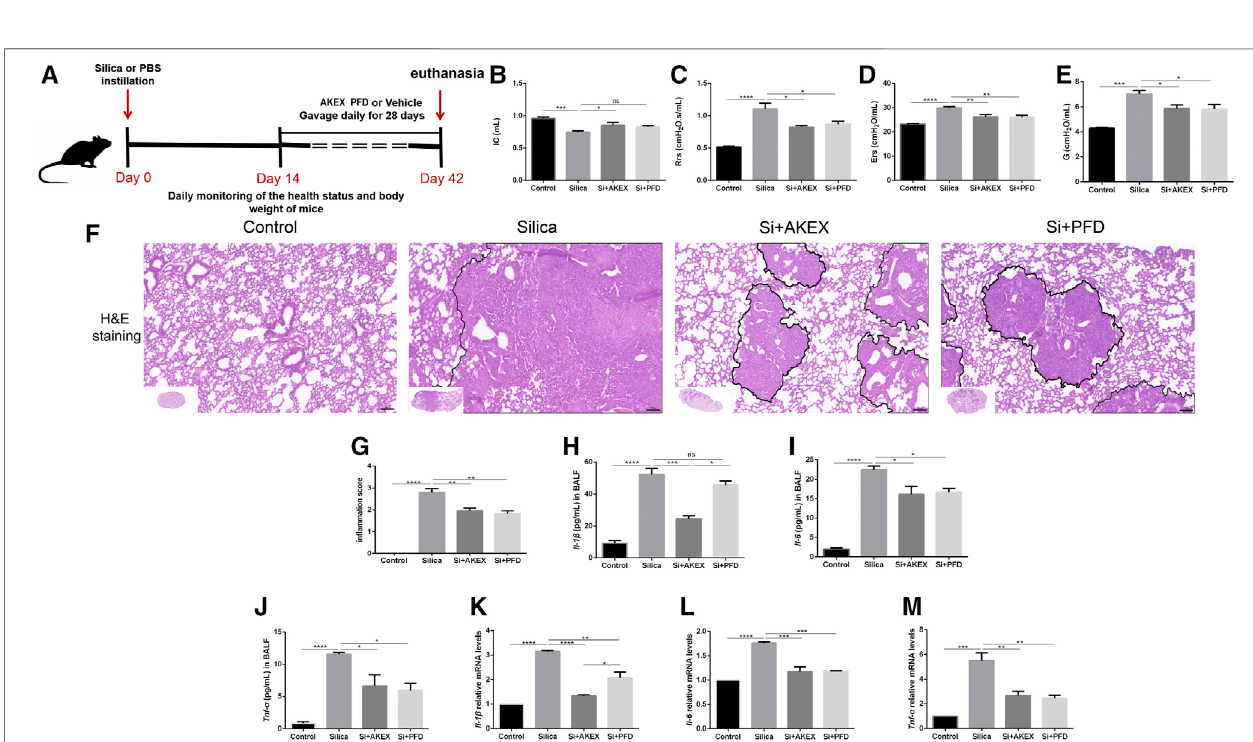
FIGURE 5 | AKEX0011 ameliorated lung function and reduced pulmonary in fl ammation in the advanced therapeutic silicosis model. (A) Experimental outline was depicted. Silicosis models were established as mentioned earlier. Mice were gavaged with AKEX0011, PFD, or vehicle at day 14 after silica exposure and drug administration for 28 days; then, they were euthanized at day 42. There were four experimental groups: PBS control (abbreviated as “ Control ” in the graphs), silica + vehicle(abbreviatedas “ Silica ” ),silica+AKEX0011(abbreviatedas “ Si+AKEX ” ),andsilica+PFD(abbreviatedas “ Si+PFD ” )in Figure5 and Figure6 . (B-E) Lung function test; IC, inspiratory capacity (n = 7-9); Rrs, respiratory resistance (n = 5-8); Ers, elastic resistance (n = 5-8); and G, tissue damping (n = 5-7). (F) H&E staining on lung sections (original magni fi cation ×100). (G) In fl ammatory score (based on H&E staining) (n = 5). (H-J) IL-1 β , IL-6, and TNF- α in the BALF detected by ELISA (n = 3). (K-M) mRNAlevels ofIL-1 β , IL-6,and TNF- α in lungtissuesweredetectedbyqPCR(n =3). All datawere presented asmean± SEM;* p < 0.05,** p < 0.01, *** p < 0.001, and **** p < 0.0001.